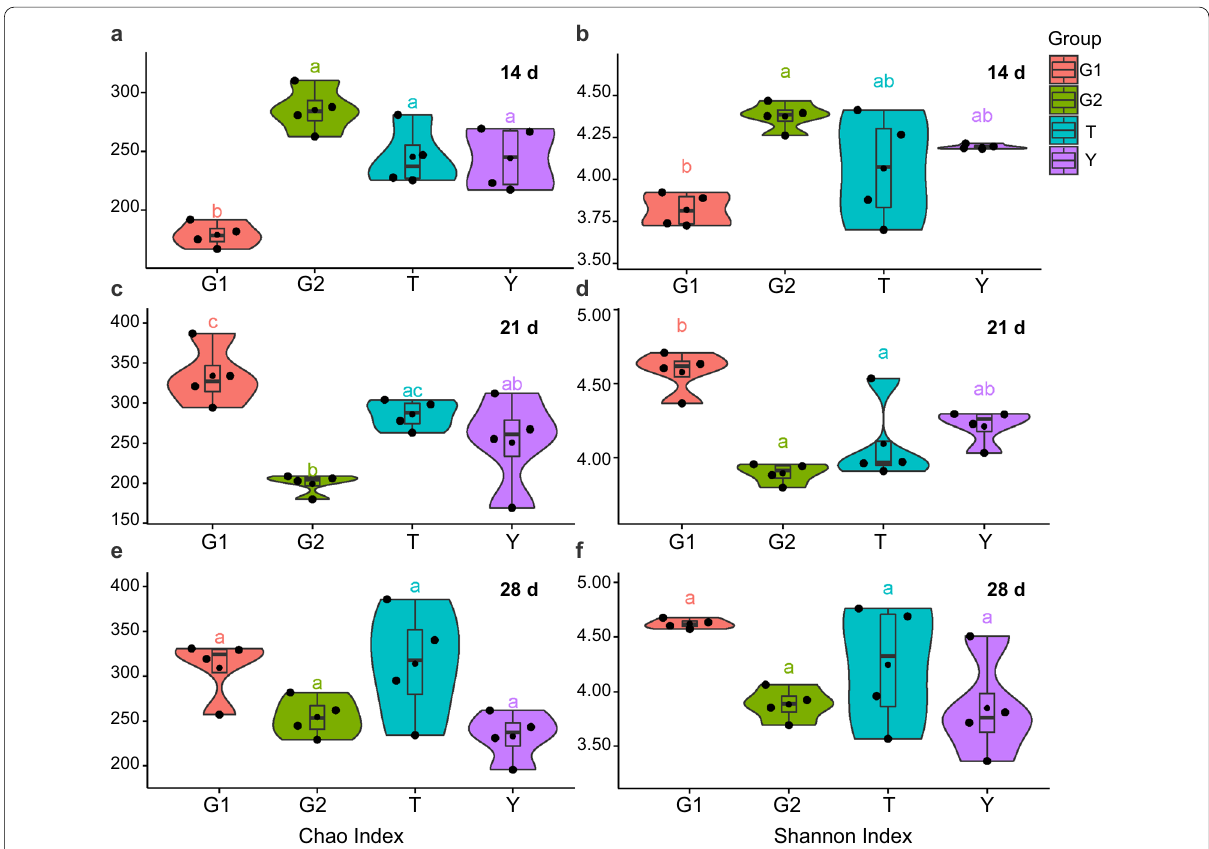
Fig. 4 Alpha diversity, including Chao index a , c , e and Shannon index b , d , f in the control group (Y), antibiotic group (T), 0.1% β-1,3/1,6-glucan (G1), and 0.2% β-1,3/1,6-glucan (G2) groups in the cecum. Data was processed through log10, expressed as mean one-way ANOVA analysis. The different superscript letters on the boxplot represent a significant difference (P <